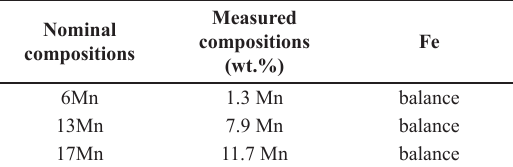
Table 1. Chemical composition of Fe-Mn alloy powders.